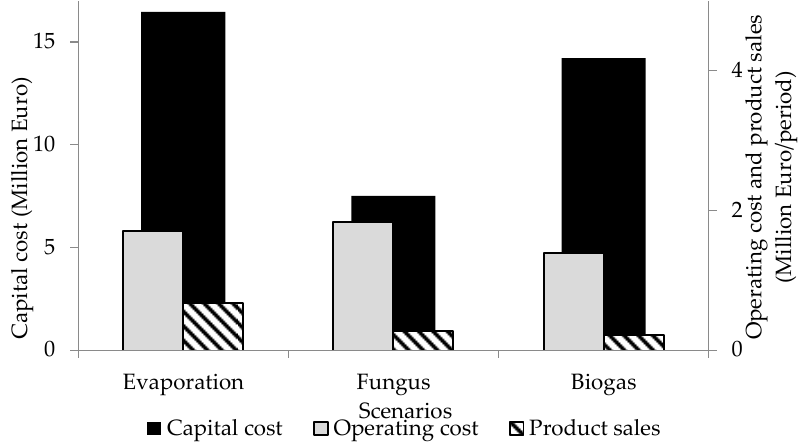
Figure 3. Results from the economic evaluation for the different scenarios considered in this study. The period is one year with six operational months.